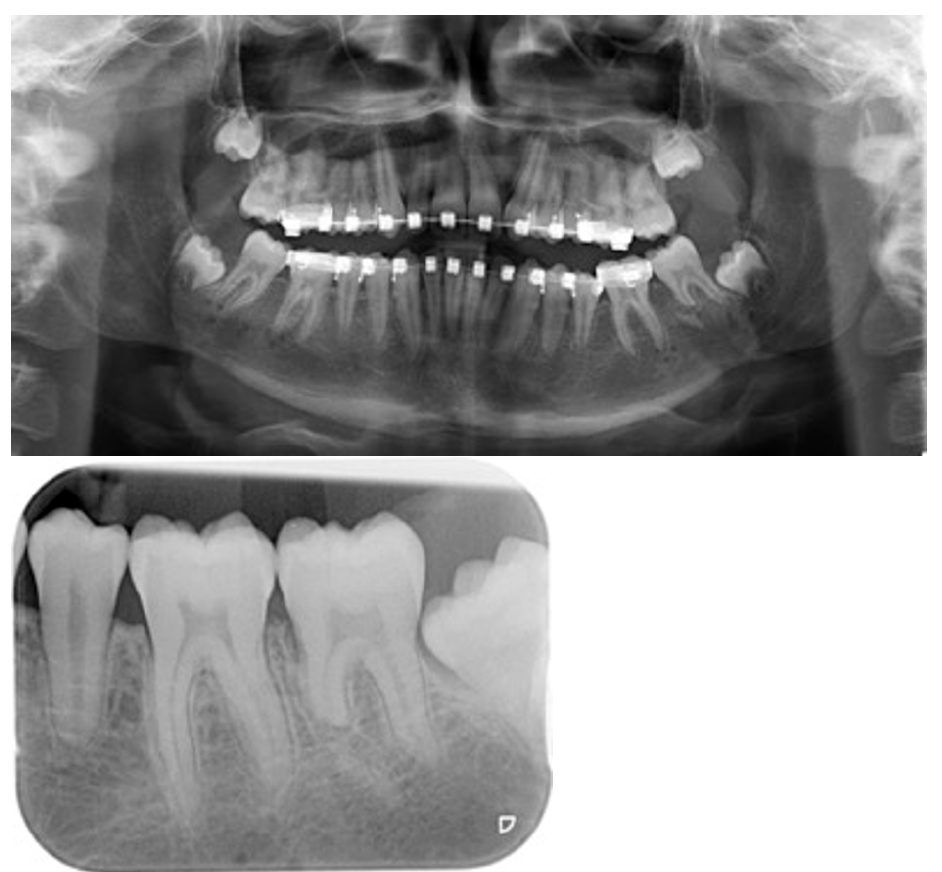
Figure 6. Postoperative x-ray documentation of an unintentional root tip amputation in the second molar in the left mandible during an IMDO treatment. Consolidation of the root stump with resorption of the root fragment.